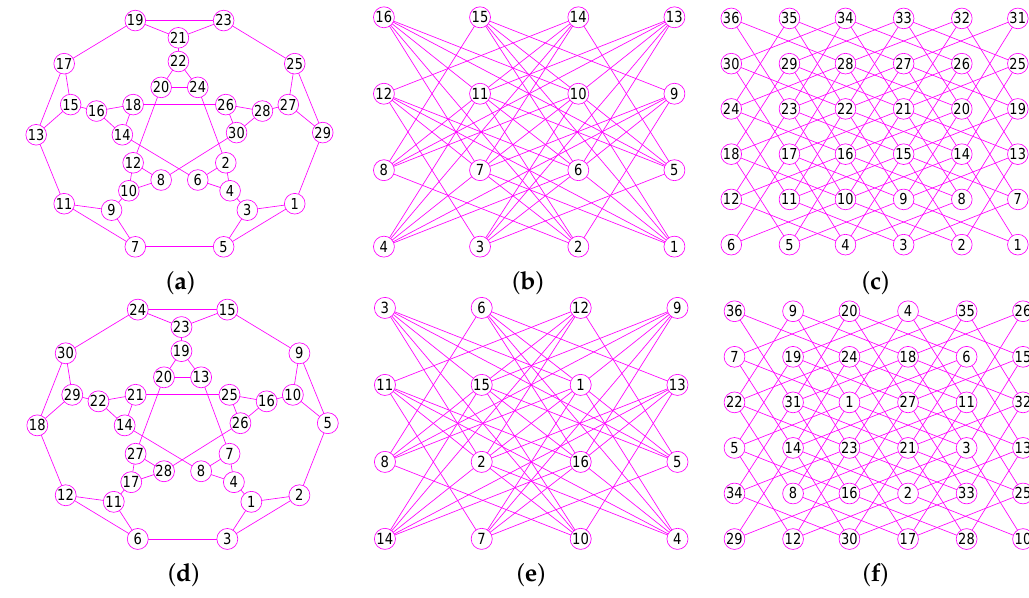
Figure 21. The TopMost graphs of three graphs G 34 , G 35 and G 36 . ( a ) A triangle-replaced graph G 34 with 30 nodes and 45 edges; ( b ) The 4-dimensional Keller graph G 35 of 16 vertices and 46 edges; ( c ) The 6 × 6 knight graph G 36 of 36 nodes and 80 edges; ( d ) The TopMost graph of G 34 ; ( e ) The TopMost graph of G 35 ; ( f ) The TopMost graph of G 36 .